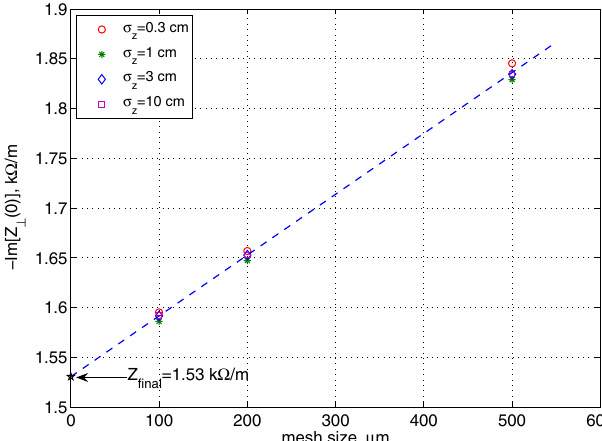
FIG. 5. (Color) Scaled wake potentials from ABCI for varying rms bunch length. Geometry is that of Fig. 2, with " (cid:6) 7 = 11 and =L (cid:6) 0 : 275 ( (cid:2) (cid:6) 173 mrad ); mesh size is 100 (cid:7) m r av